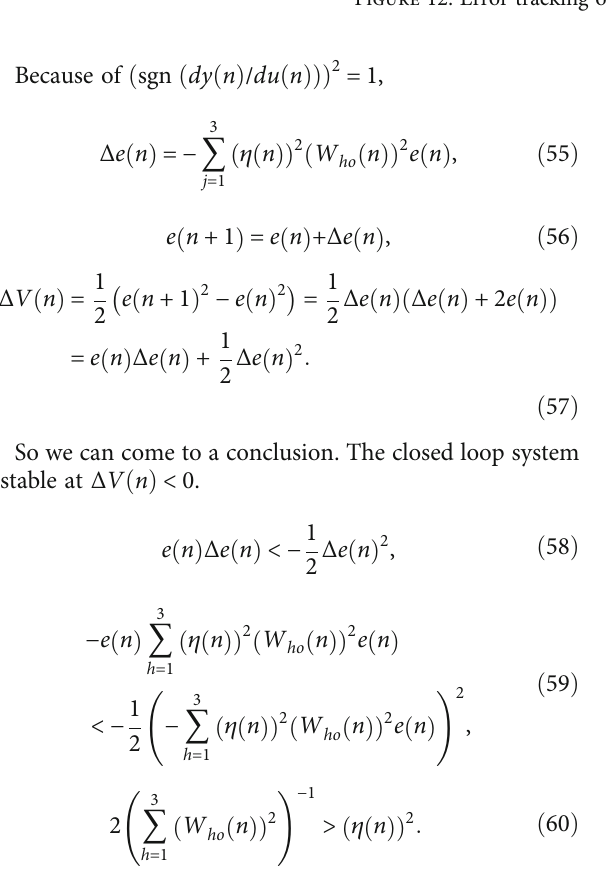
Figure 12: Error tracking of the second motion